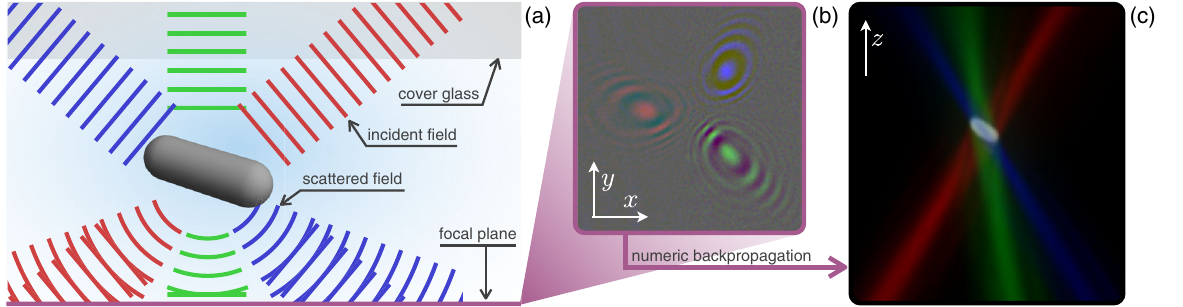
FIG. 1. Working principle of three-axis holographic microscopy. (a) The sample is illuminated by three partially coherent beams having different colors and directions. (b) The resulting hologram arising from the interference between scattered and unscattered light is acquired by a RGB camera. (c) A volumetric image of the sample is obtained as the overlap of three independent reconstructions obtained by numerically backpropagating the holograms (see also Ref. [48]).